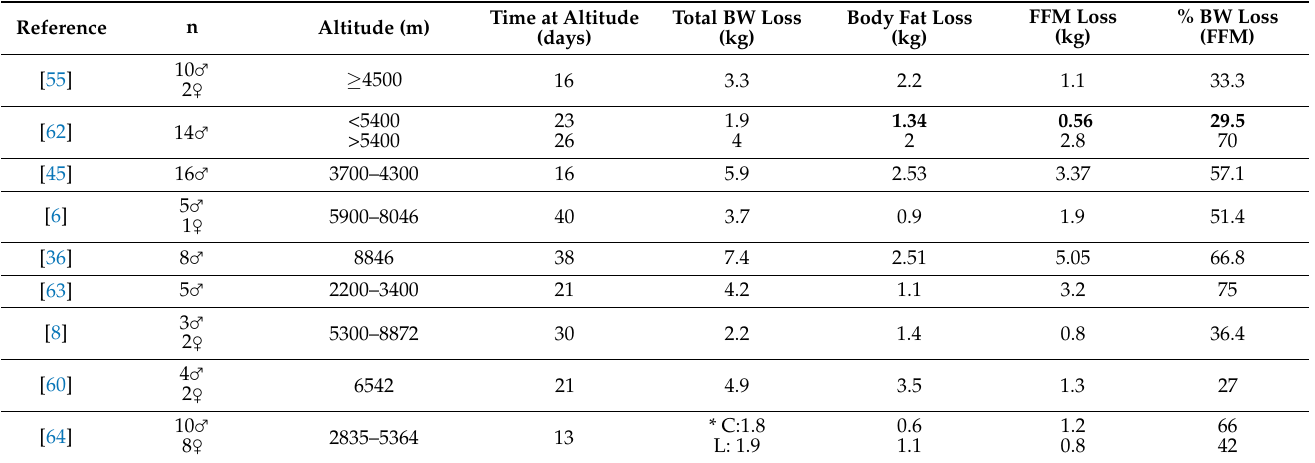
BW: Body weight. FFM: Fat-free mass. Men